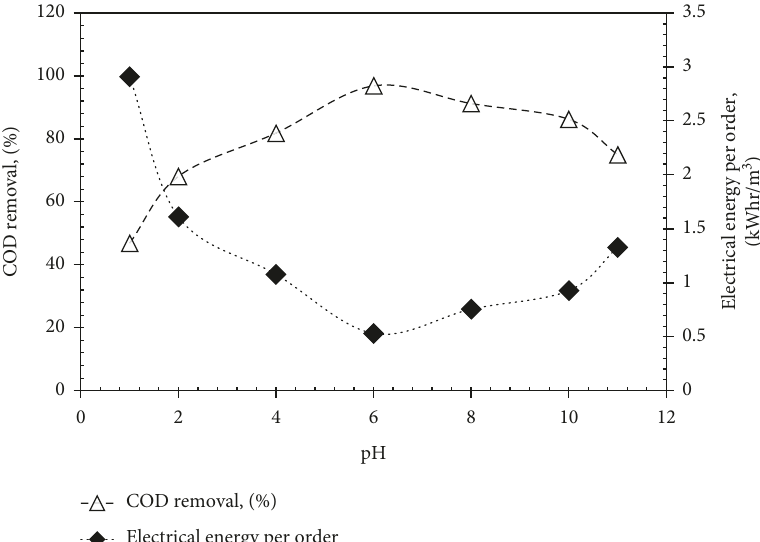
Figure 5: Effect of pH on % COD removal and EE/O in the O time–4 h; O 3 flow rate and production–20 LPM and 4g/h; H 2 O 2 –100mM; Fe 2+ –20mM; and